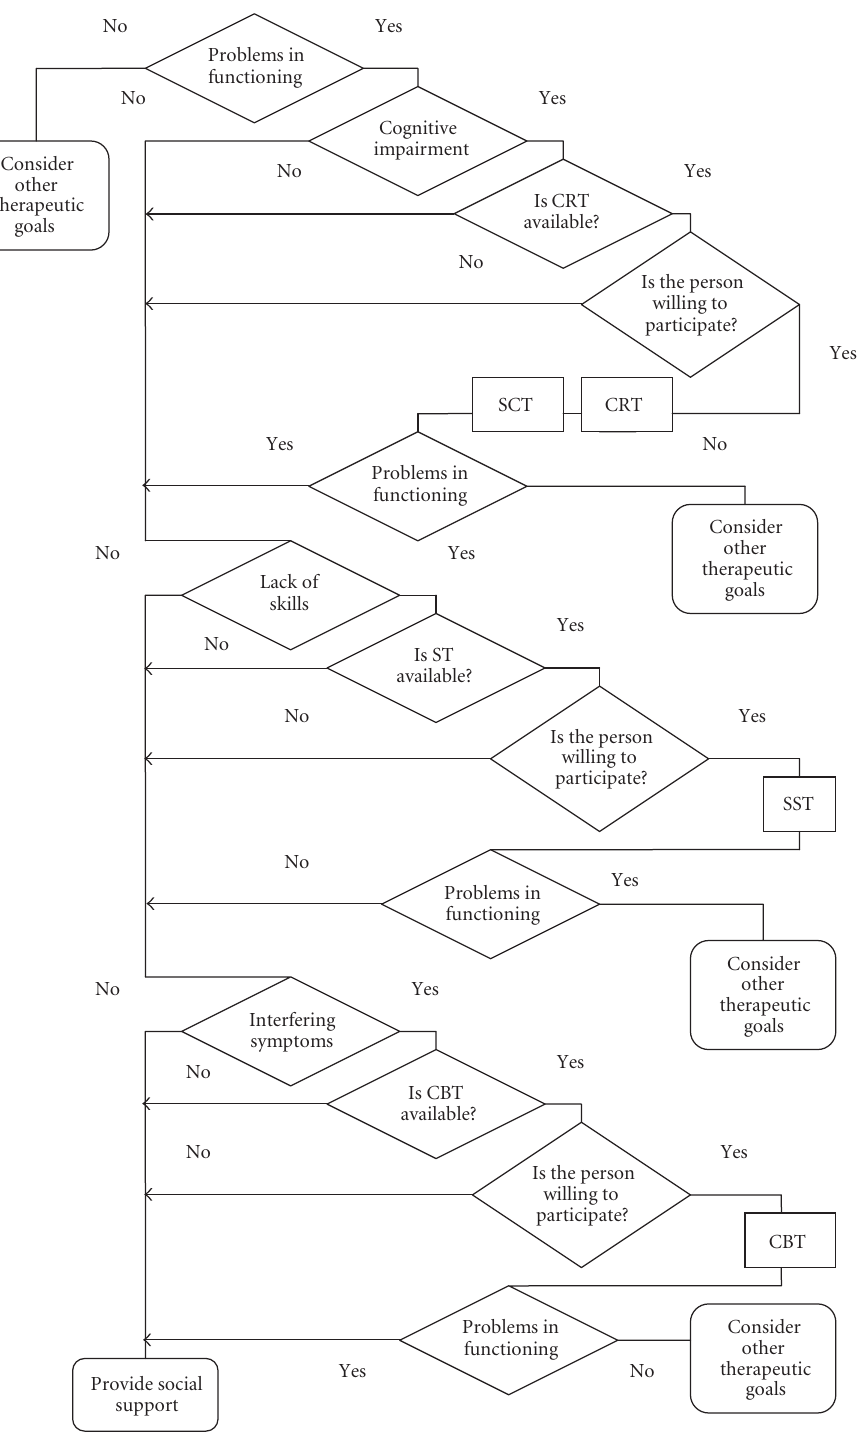
Figure 3: Flowchart to integrate cognitive remediation with other psychological interventions. CRT: cognitive remediation therapy; SCT: social cognition therapy; SST: social skills training; CBT: cognitive behavioral therapy.